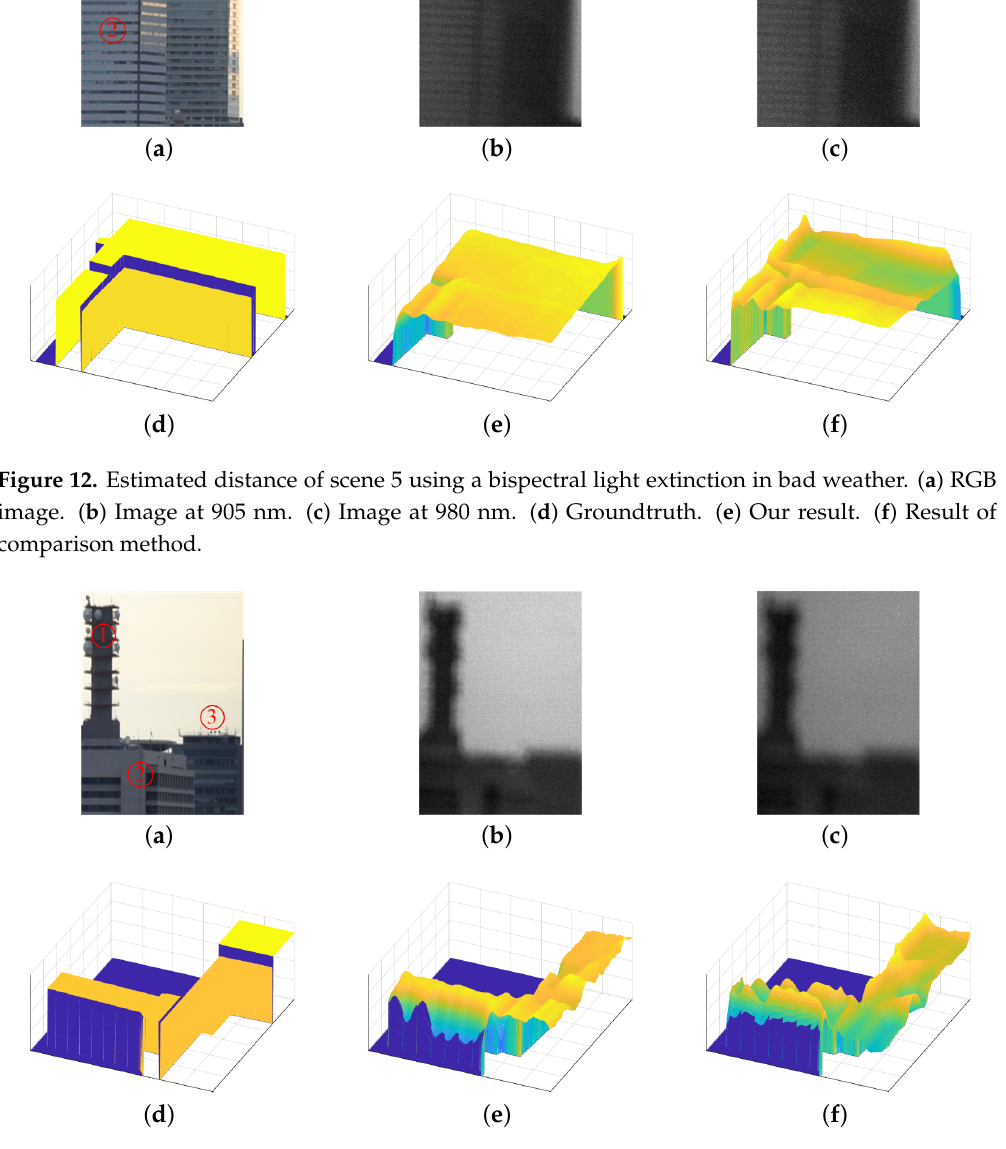
Figure 13. Estimated distance of scene 6 using a bispectral light extinction in bad weather. ( a ) RGB image. ( b ) Image at 905 nm. ( c ) Image at 980 nm. ( d ) Groundtruth. ( e ) Our result. ( f ) Result of comparison method.